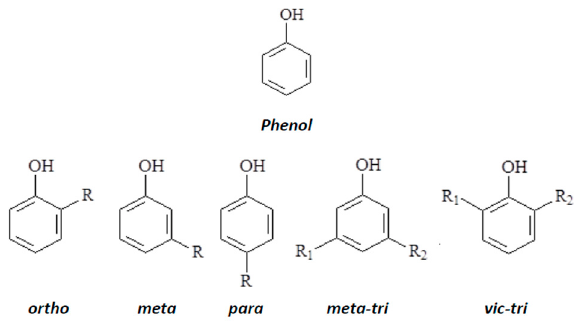
Figure 1. Structure and nomenclature for phenol and substitution patterns of phenolic compounds.